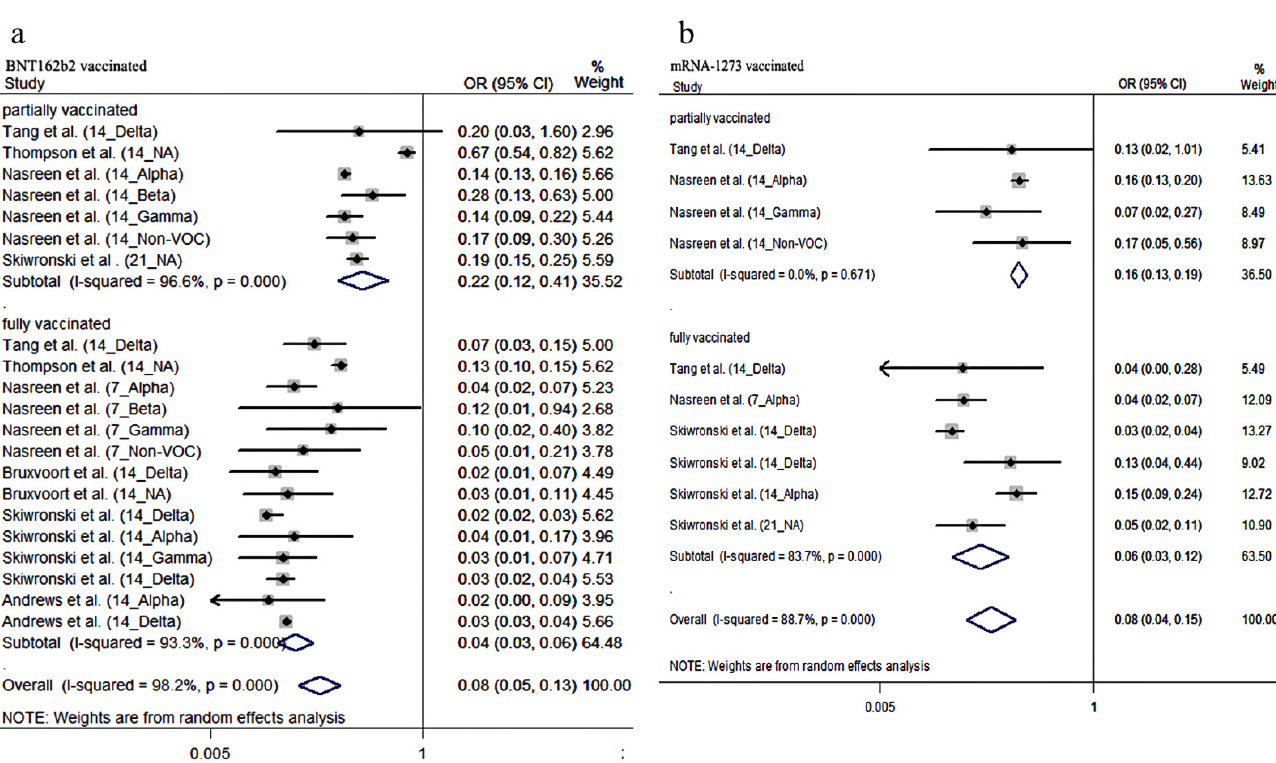
Figure A1. Forest plot odds ratio (OR) against hospitalization. ( a ) : OR with 95% confidence intervals (CI) against COVID-19 hospitalization after being vaccinated (BNT162b2); ( b ) : OR with 95% confidence intervals (CI) against COVID-19 hospitalization after being vaccinated (mRNA-1273).